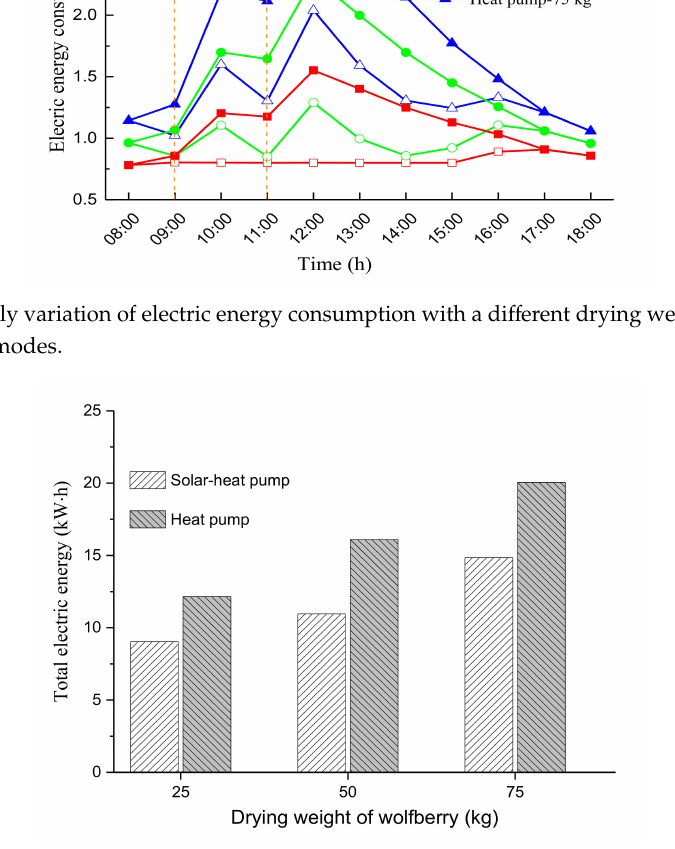
Figure 15. Variation of total electric energy consumption with a di ff erent drying weight of wolfberry.